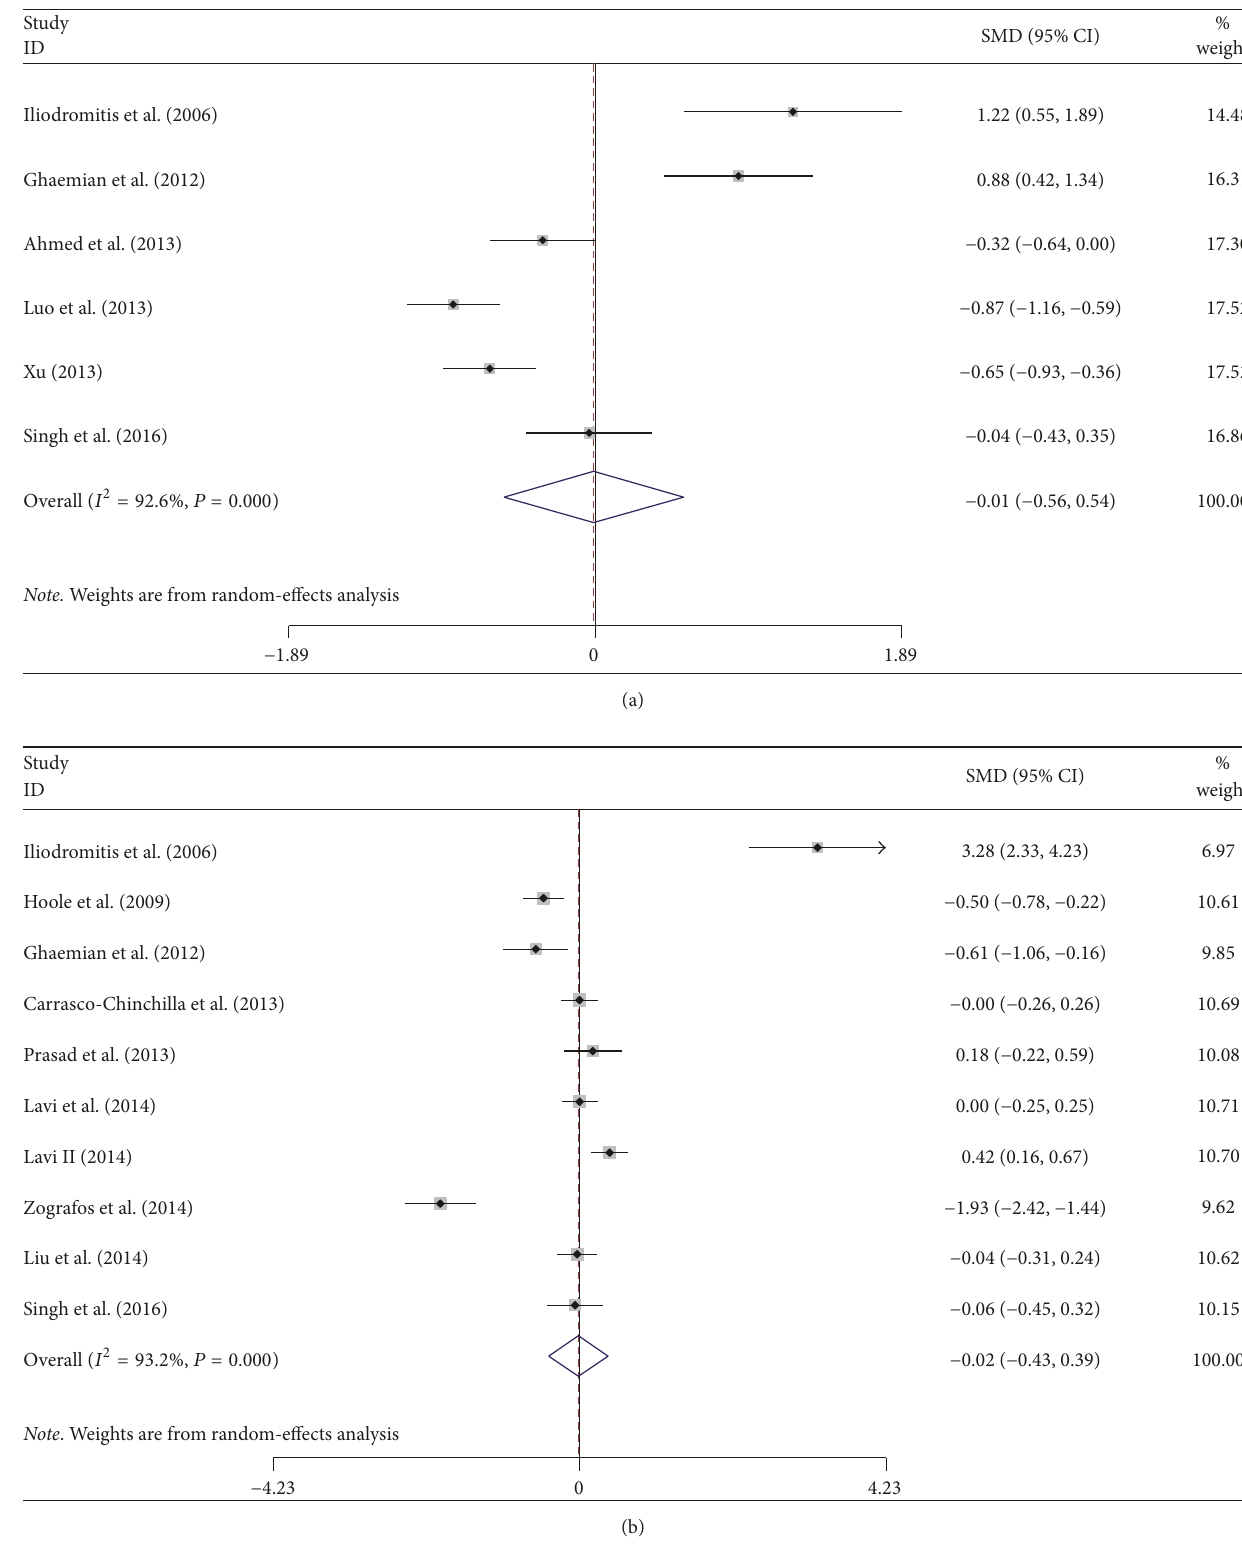
Figure 5: Forest plot for myocardial biomarkers expressed as SMD within 12 h (a) and 24 h (b) after PCI. SMD: standardized mean